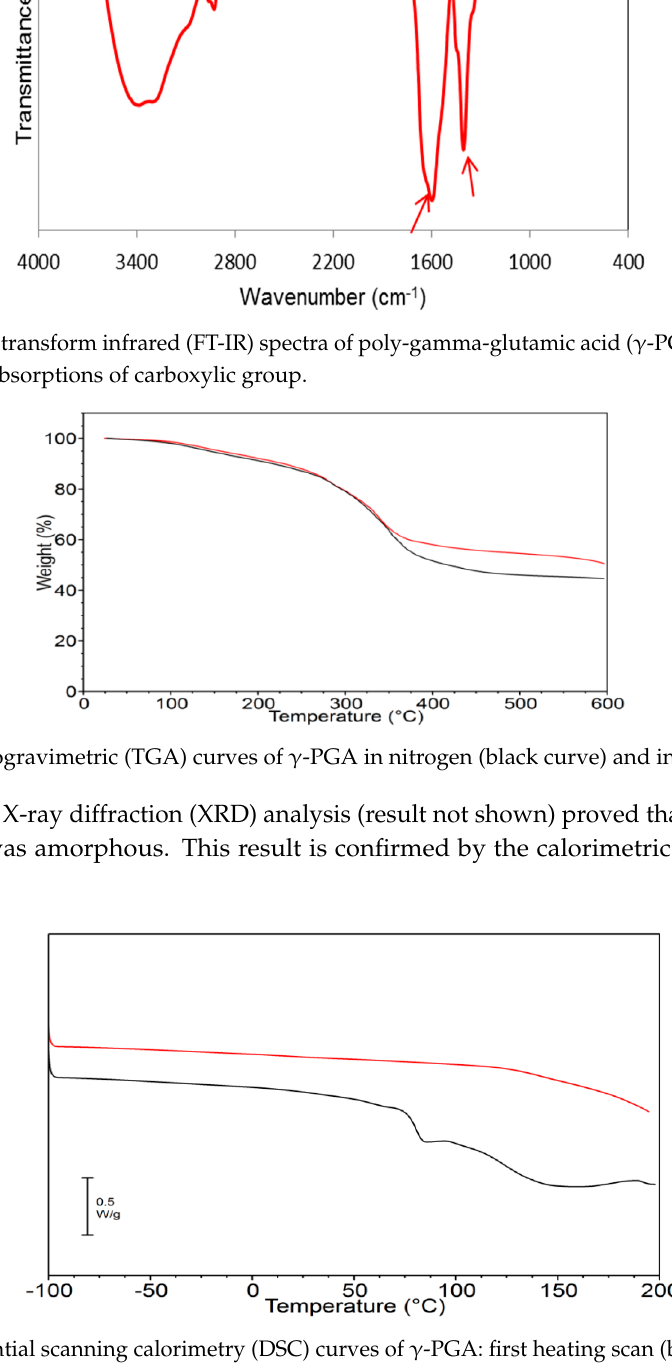
Figure 3. Differential scanning calorimetry (DSC) curves of γ -PGA: first heating scan (black curve) and second scan after quench-cooling from the melt (red curve).